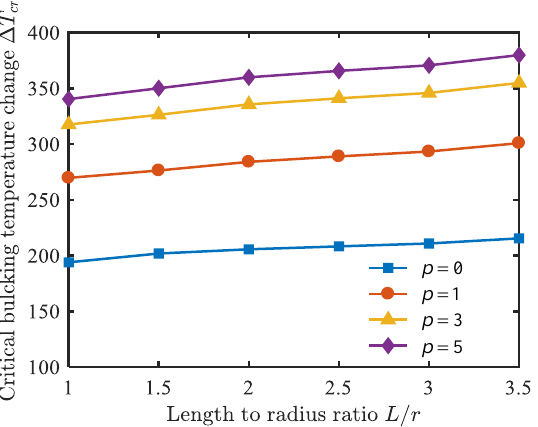
Figure 5. Influence of the length-to-radius ratio of the conical shell on critical buckling temperature change.